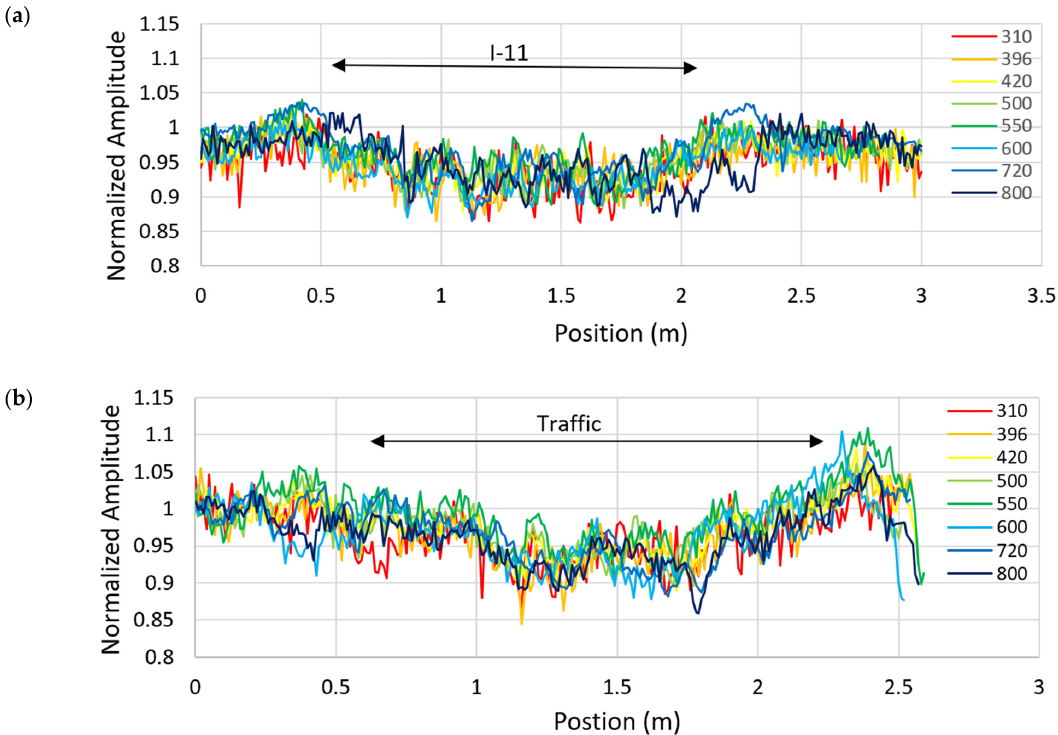
Figure A8. 1.5 GHz Norm. DW amplitudes on sand (I-11) in the ( a ) long. and ( b ) transv. direction vs. K loadings.